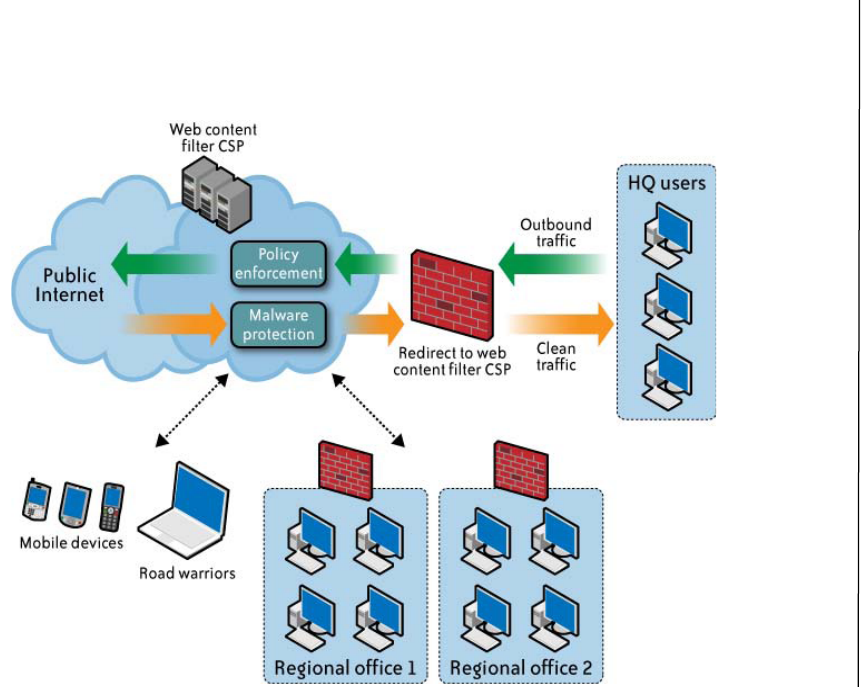
Figure 4 – Filtering of the web content in the BkS model (Mather et al,